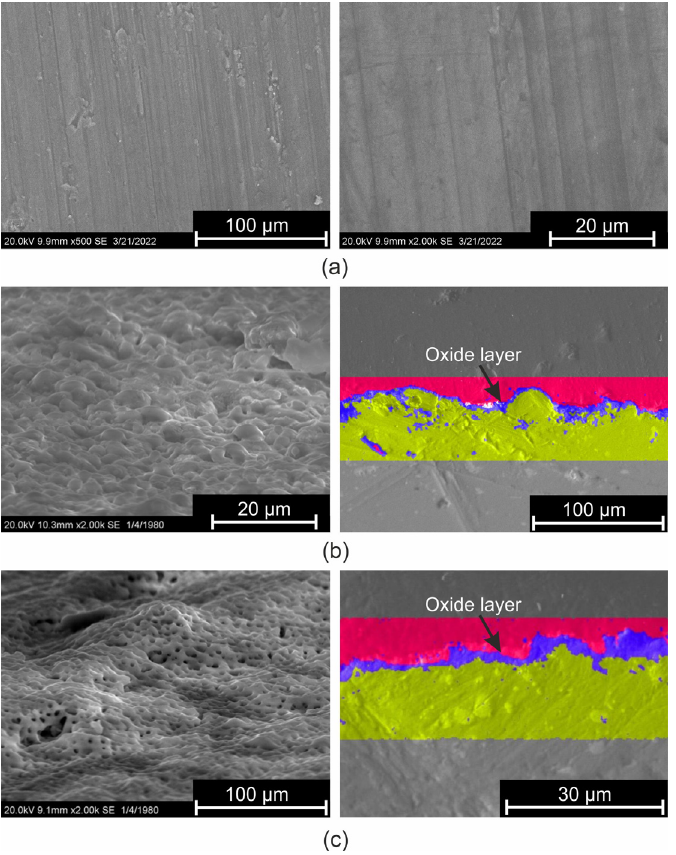
Figure 2. Structure of the heaters: ( a ) SEM of the smooth sample; ( b ) SEM and EDX of sample No. 1; ( c ) SEM and EDX of sample No. 2.